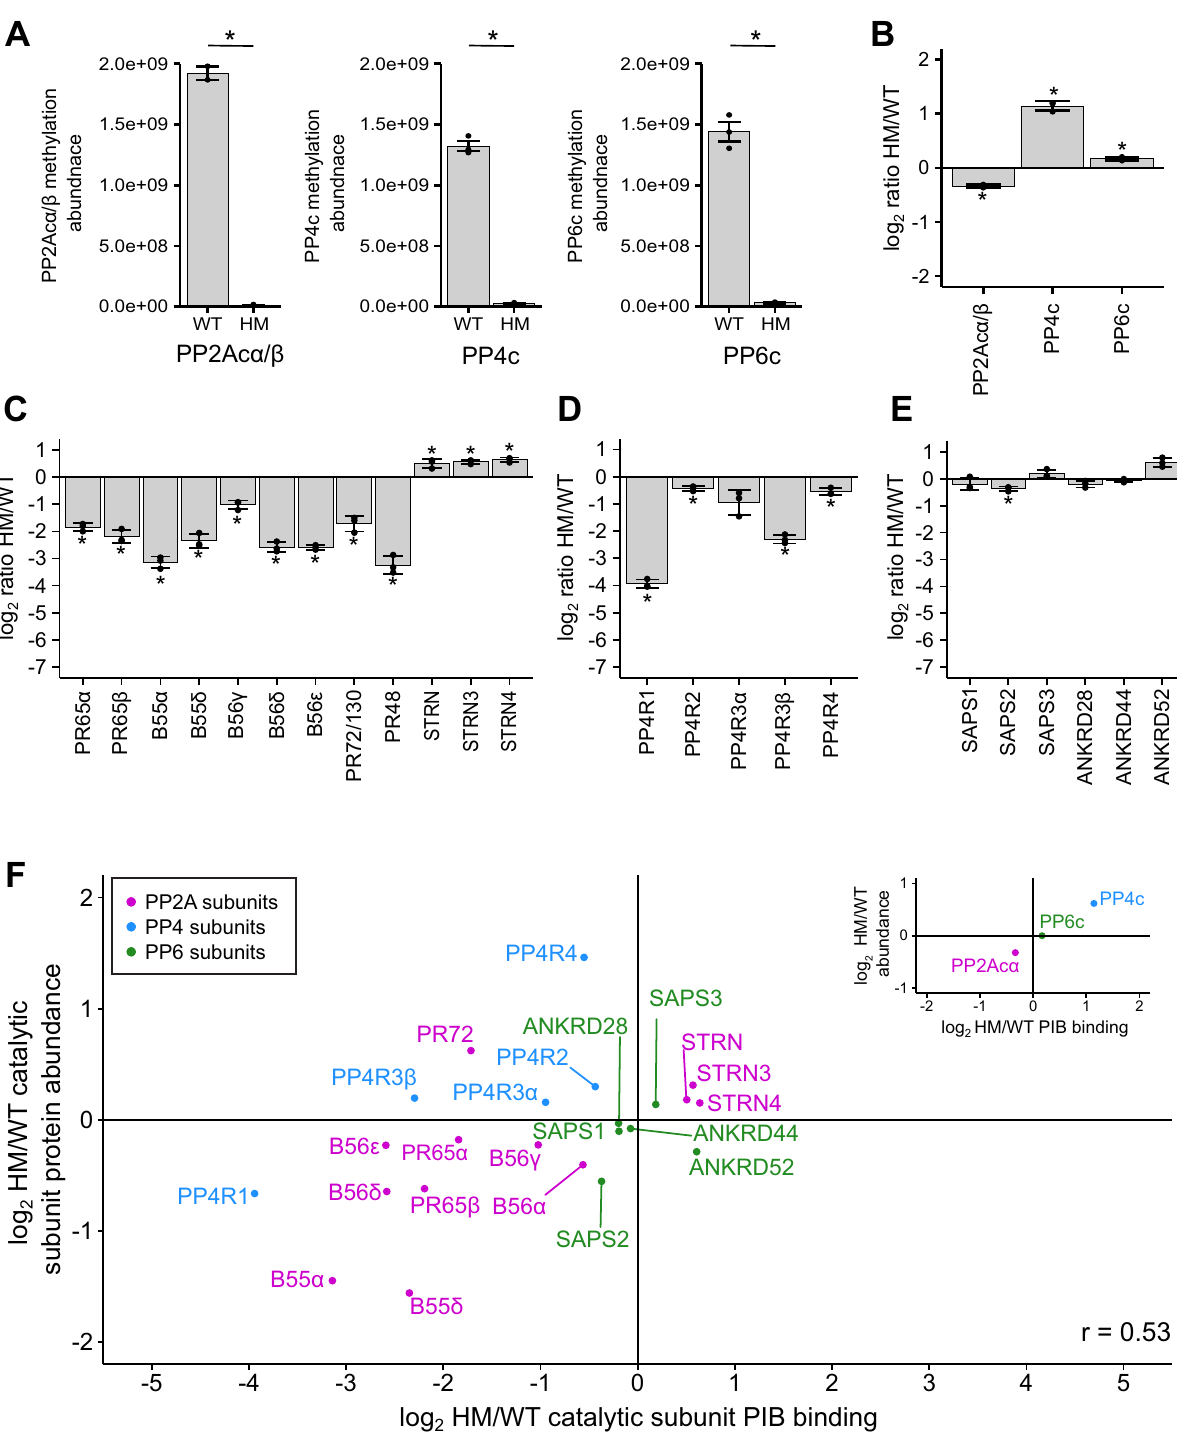
Figure 4. The effects of disrupting LCMT1expression in HEK293T cells on the holoenzyme composition of PP2A, PP4, and PP6. ( A ) Normalized peptides intensities of methylated peptides in wild-type (WT) and hypomorph (HM) cells. Methylated peptides were normalized to the total protein amount of the respective catalytic subunit. Triplicates are plotted and shown as separate points. Error bars represent the standard deviation. The log 2 ratio HM/WT of the protein abundance of the catalytic subunits ( B ), PP2A subunits ( C ), PP4 subunits ( D ), and PP6 subunits ( E ) enriched by phosphatase inhibitor beads (PIBs) and determined by label-free mass spectrometry. ( F ) Scatterplot depicting the log2 HM/WT ratio of PP2A, PP4, and PP6 subunits bound to PIBs and normalized to the respective catalytic subunit on the x-axis and the log 2 HM/WT ratio protein abundance on the y-axis. PP2A subunits are labeled in purple, PP4 subunits are in blue, and PP6 subunits are in green. The scatterplot in the upper right depicts catalytic subunits PIB binding versus protein abundance. Two-sided Student’s t-test was performed, assuming unequal variance * p <